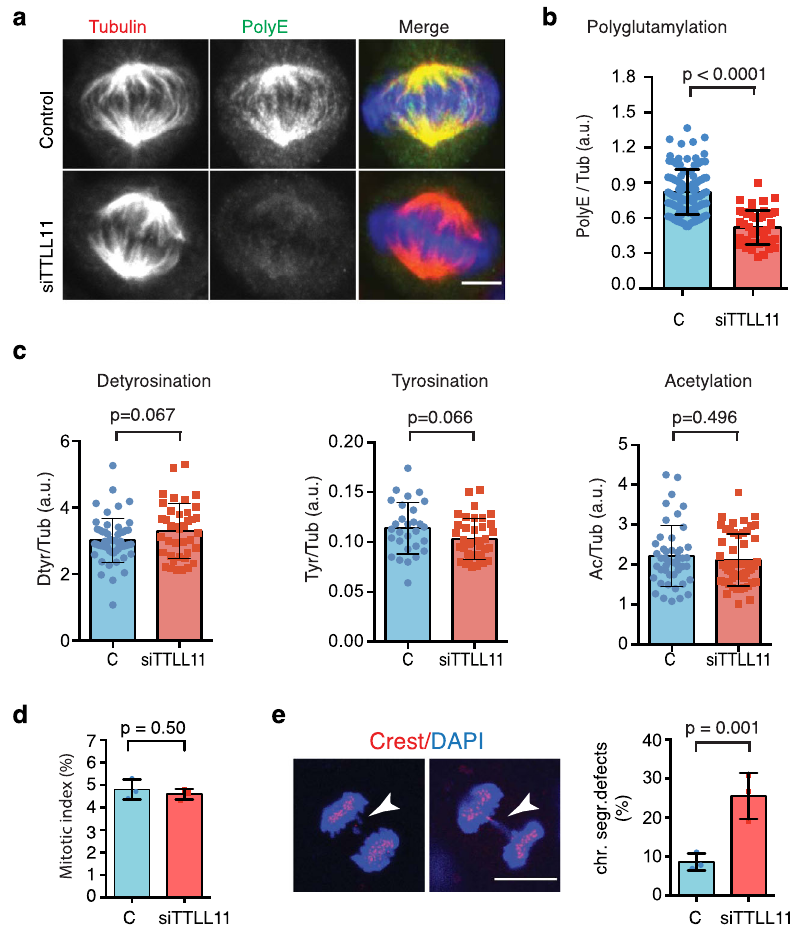
Fig. 1 | TTLL11 localizes to the spindle and drives MT polyglutamylation in mitosis. a Immuno fl uorescence images of metaphase spindles in control and siTTLL11HeLacells,showingPolyE(green),tubulin(red)andDNA(blue).Scalebars, 10 μ m. b Quanti fi cation of the polyEsignalnormalized to the totaltubulinsignalin control and siTTLL11 spindles. n (control)=105 cells and n (siTTLL11)=50 cells. Graph representative of N =5 independent experiments. Data are presented as mean values+/ − SD. c Quanti fi cation of immuno fl uorescence signal for detyr- osinated, tyrosinated and acetylated tubulin normalized to the total tubulin signal in control and siTTLL11 spindles. Detyrosination: n (control)=55 cells and n (siTTLL11)=39 cells; Tyrosination: n (control)=29 cells and n (siTTLL11)=37 cells. Acetylation: n (control)=37 cells and n (siTTLL11)=37 cells. Graphs representative